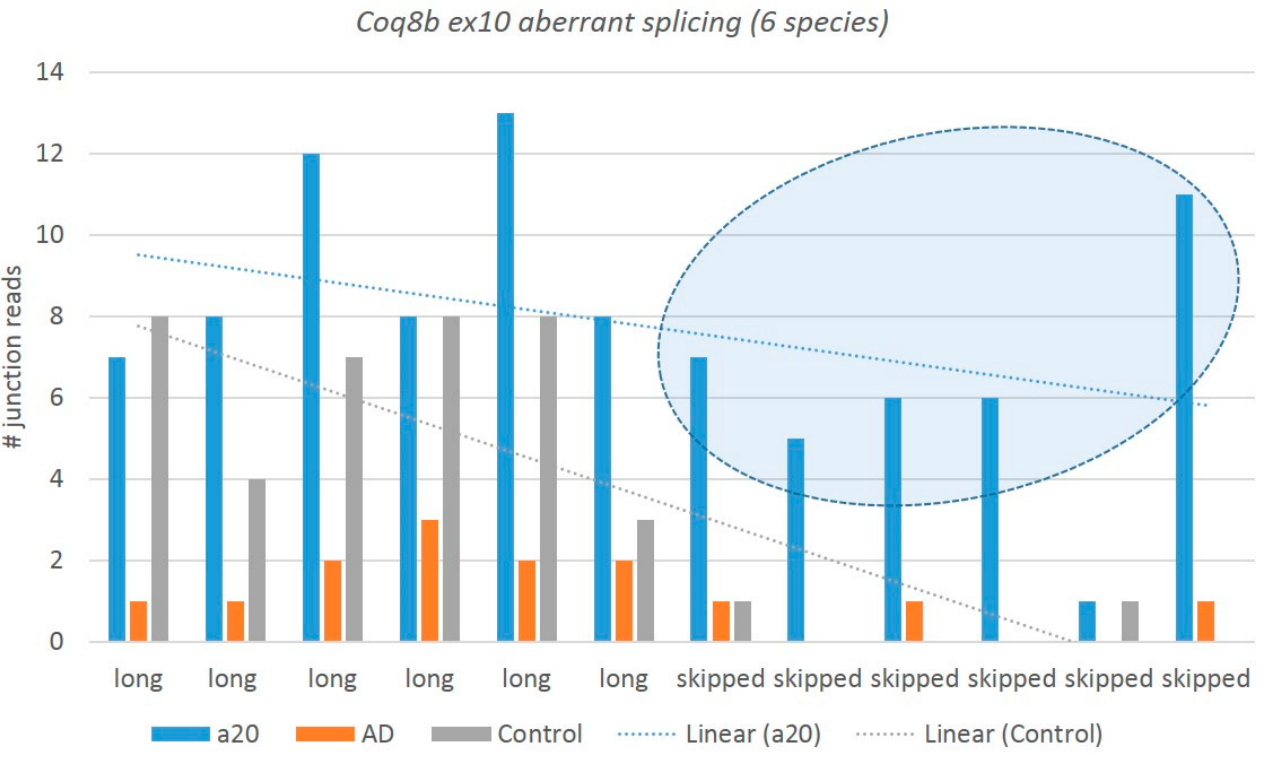
Figure 14. Six mice per group are shown; the ordinate shows the numbers of long/skipped junctions (Figure 2). The elevated junction numbers of Coq8b ex10 aberrant isoforms (exon skipping is subject to NMD) are encircled in aggressive species (blue bars). The significance of the FDR value of differentially spliced transcript ratios is 0.0028 for C_A20 comparison and 0.012 for AD_A20 (Table S2a).